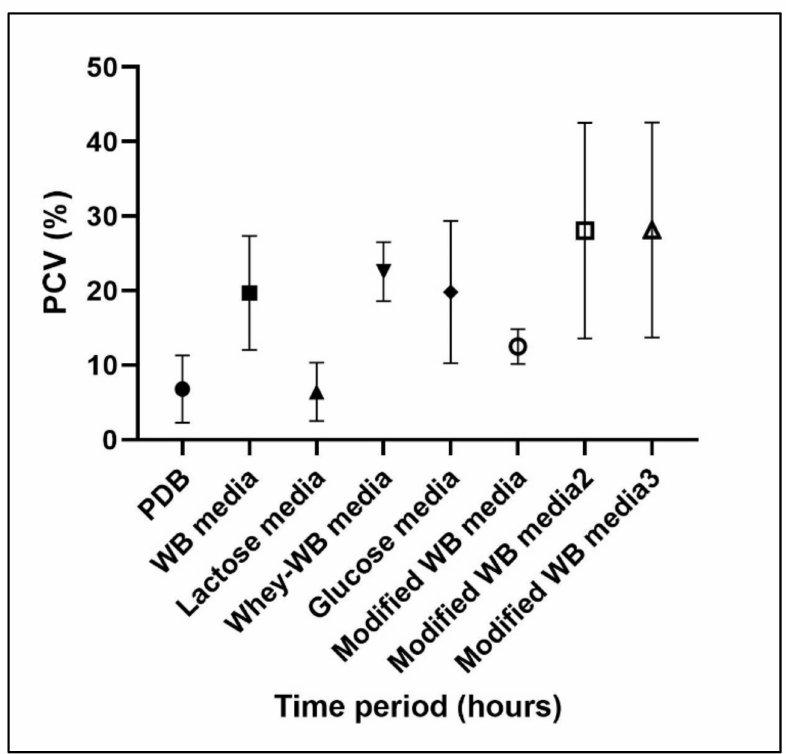
Figure 2. Fungal growth in terms of PCV (packed cell volume) in different production media.